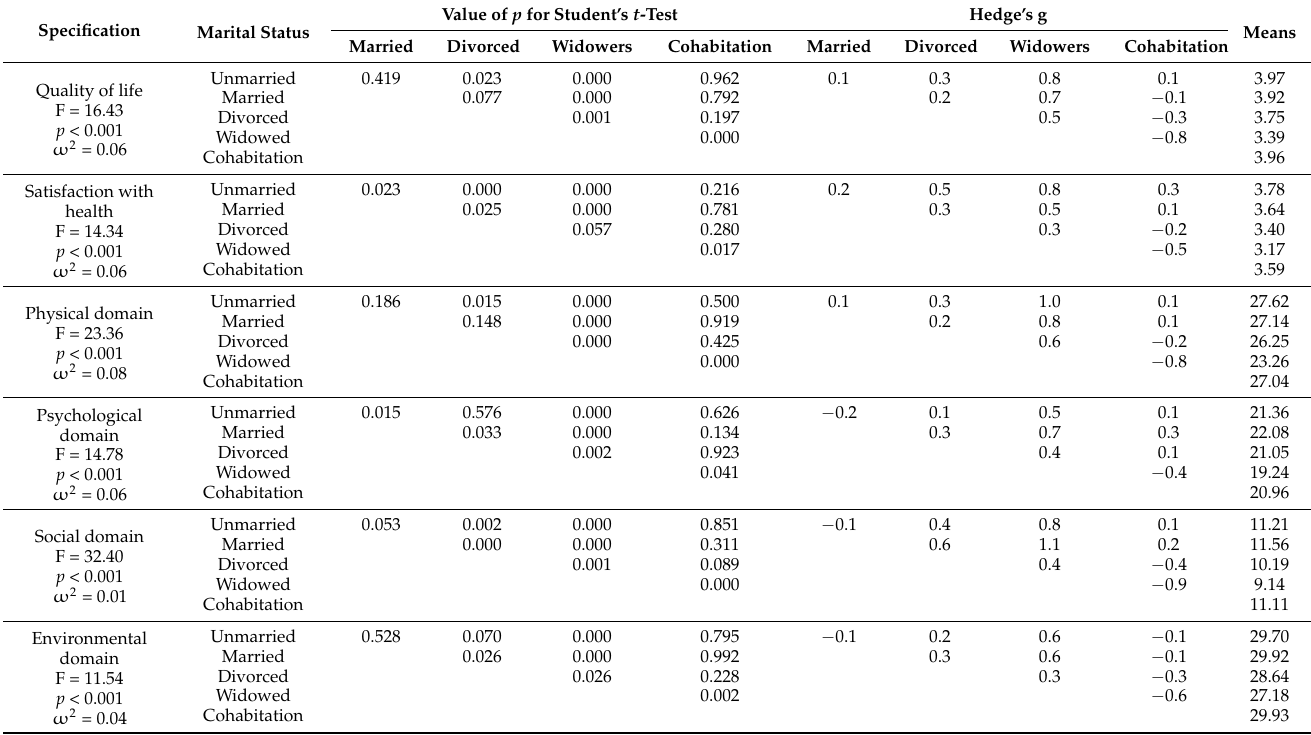
Table 3. Marital status vs. quality of life reported by students, their parents, and their grandparents (F-test, ω 2 , t -test, Hedges’ g).